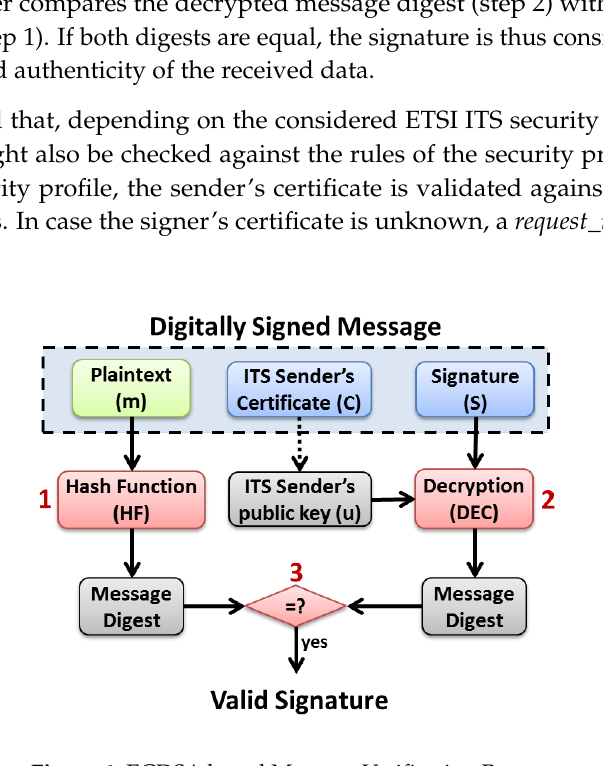
Figure 6. ECDSA based Message Verification